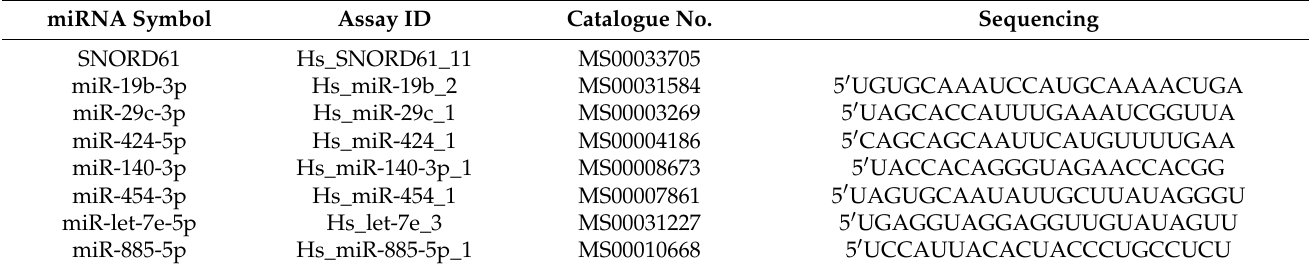
Table 3. Specific miScript primer assays used for